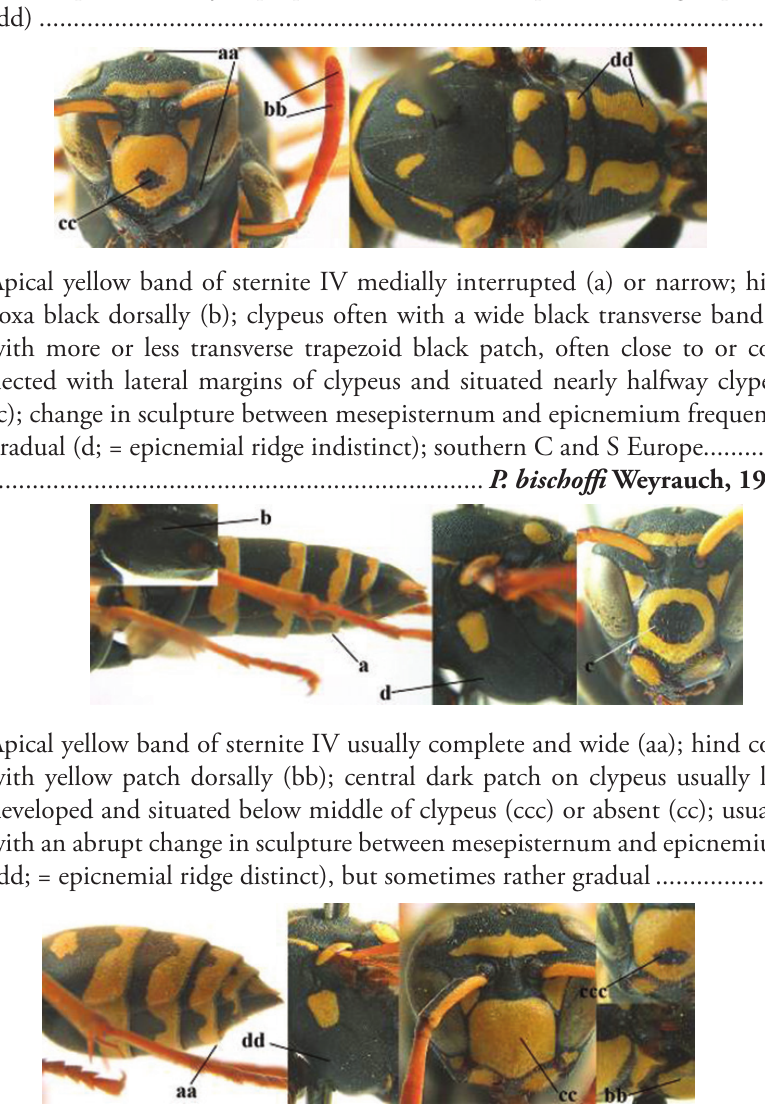
(cc; except in P. bischoffi ); propodeal and metanotal spots according to picture (dd) .......................................................................................................... 19